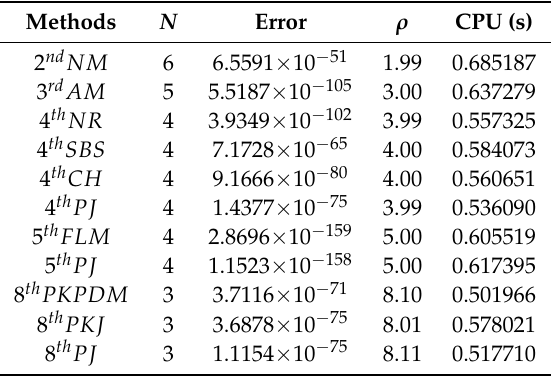
Table 6. Comparison of results for Application